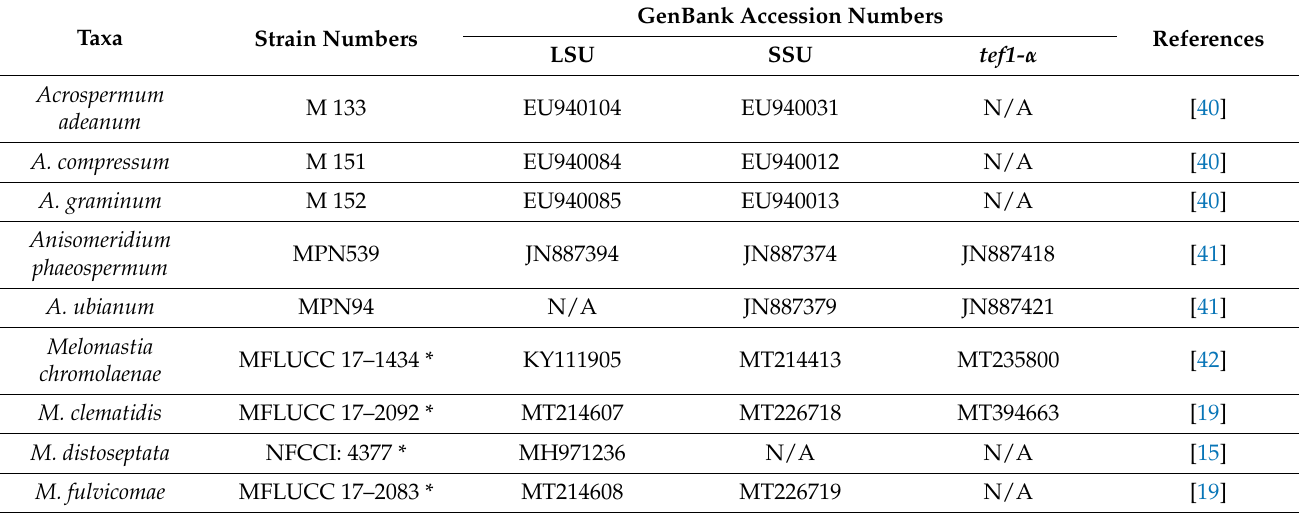
Table 1. Taxa used in the phylogenetic analyses and their GenBank accession